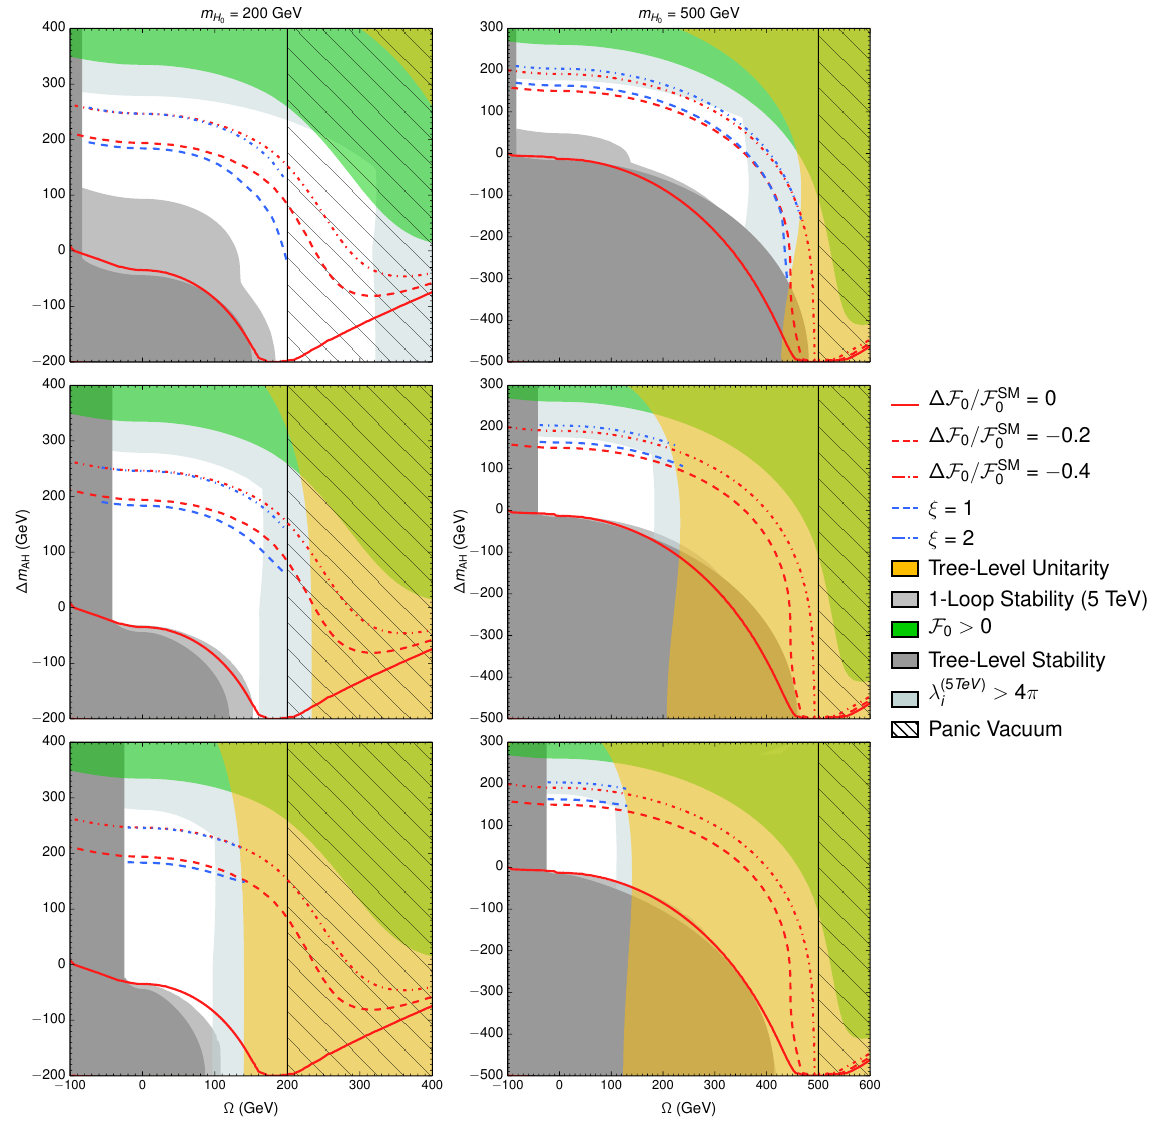
p Figure 6 . (cid:10) (cid:10) 2 sign((cid:10) 2 ) vs (cid:1) m AH (cid:17) j j (cid:2) 200 ; 500 GeV (Left to Right) and t (cid:12) = 1 : 5 ; 3 ; 5 (Top to Bottom). Red lines show constant values SM of (cid:1) = . Blue lines show constant values of the strength of the EWPT (cid:24) . The grey region is 0 F 0 F excluded by boundedness from below of the scalar potential, while the brown region is excluded by unitarity. In the hatched region, a panic vacuum